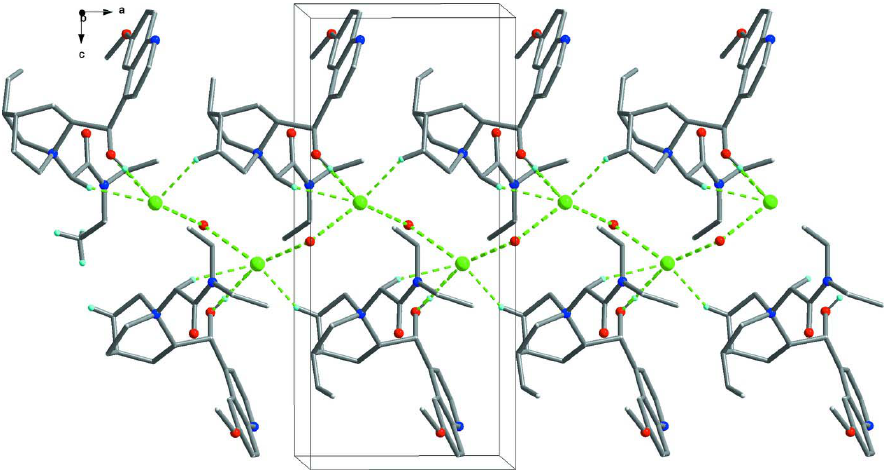
Figure 2 The molecular packing of the title compound, viewed along the b axis. H atoms not involved in hydrogen bonding have been